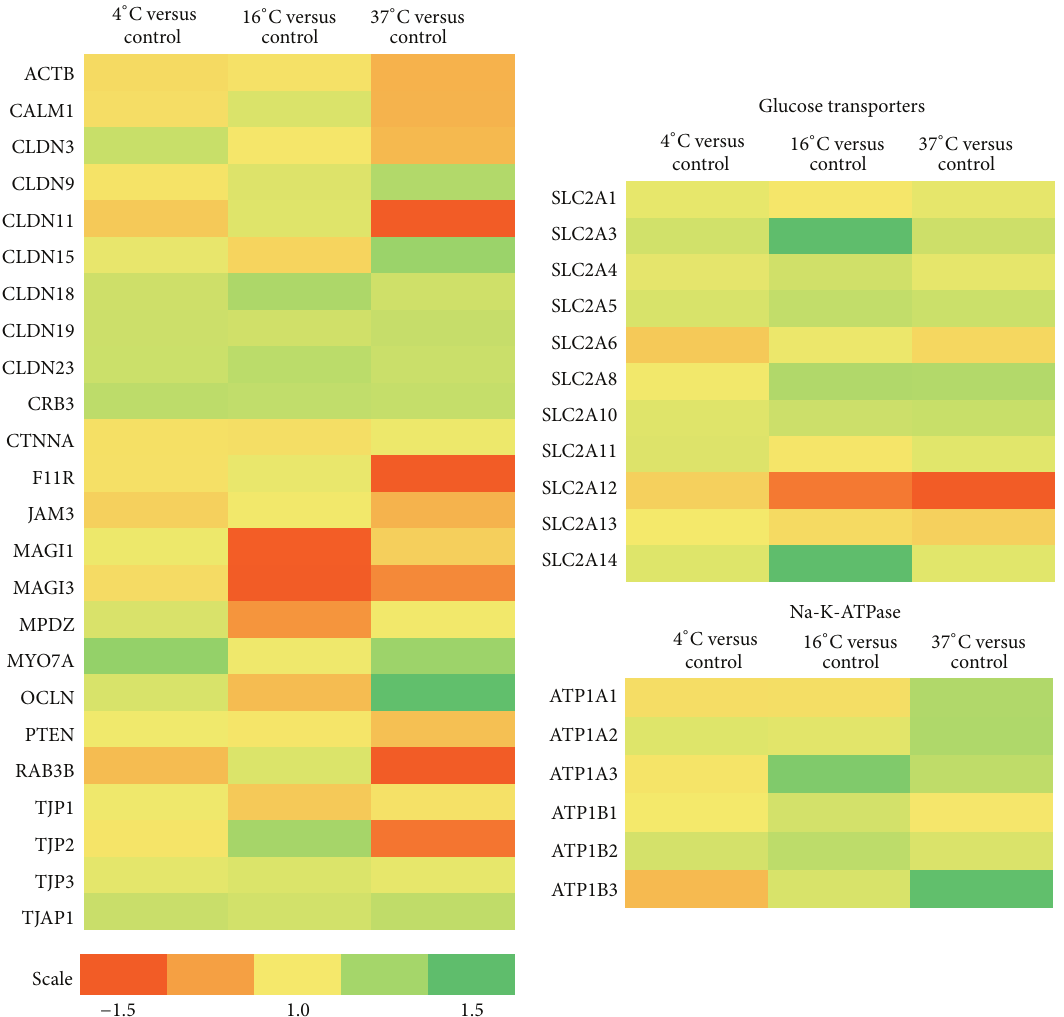
Figure 2: Heat map diagrams of a selection of the most important genes related to RPE tight junctions, glucose transportation, and Na-K- ATPase, respectively. The color scale illustrates the relative expression level of mRNAs: green color represents a high expression level and orange color represents a low expression